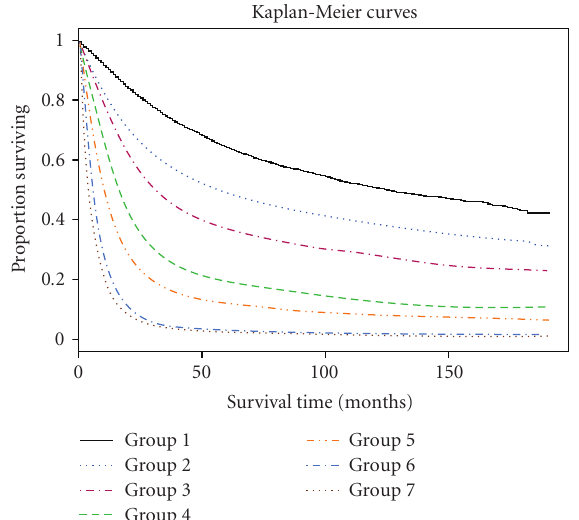
Figure 2: Survival curves of seven groups in Table 3.